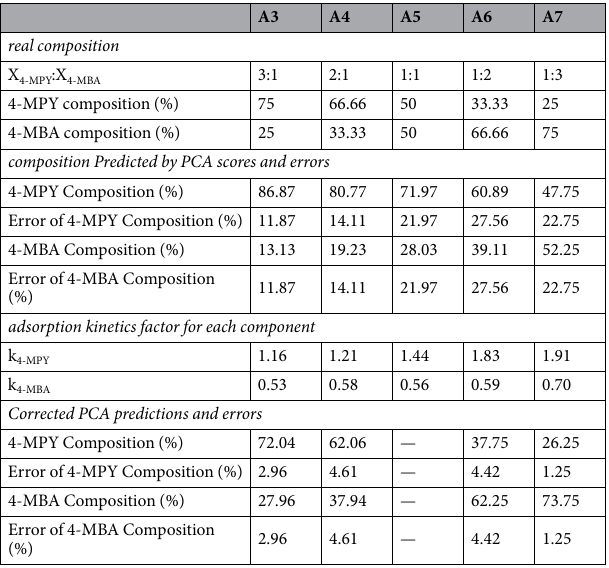
Table 1. Real composition in solution, composition predicted by PCA scores and errors, adsorption kinetics factor for each component, corrected PCA predictions, and errors for binary sample A3 to